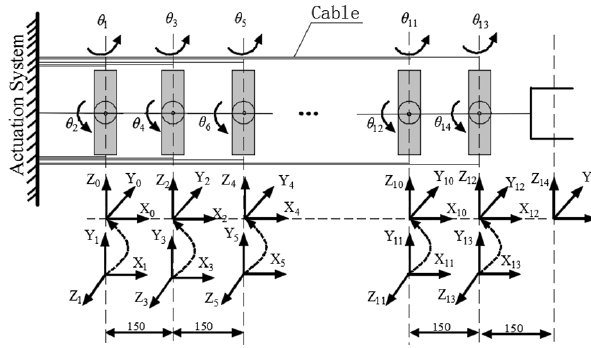
Figure 6. Kinematic parameters of the CDSLM.